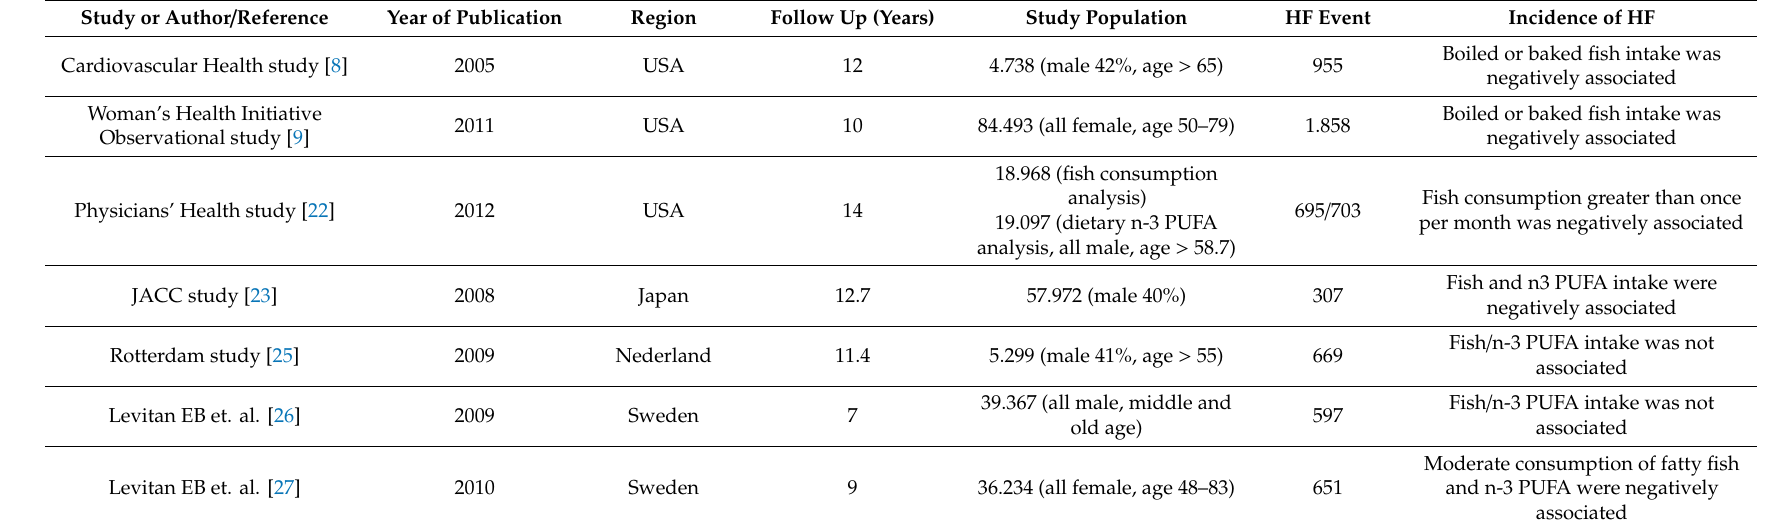
Table 1. Primary prevention of heart failure (HF) clinical